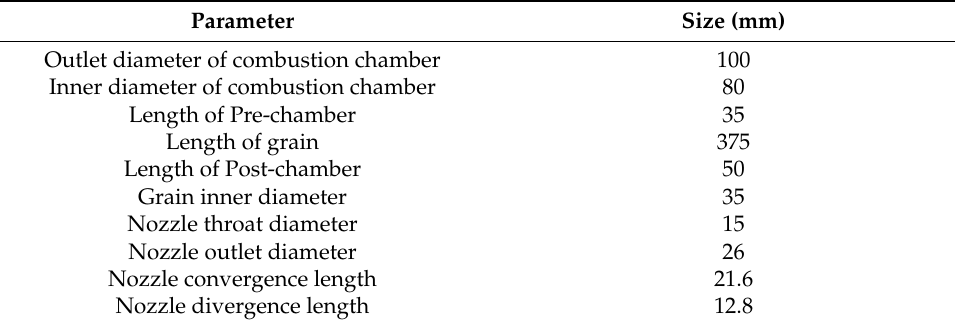
Figure 3. Average regression rate at different grid numbers.